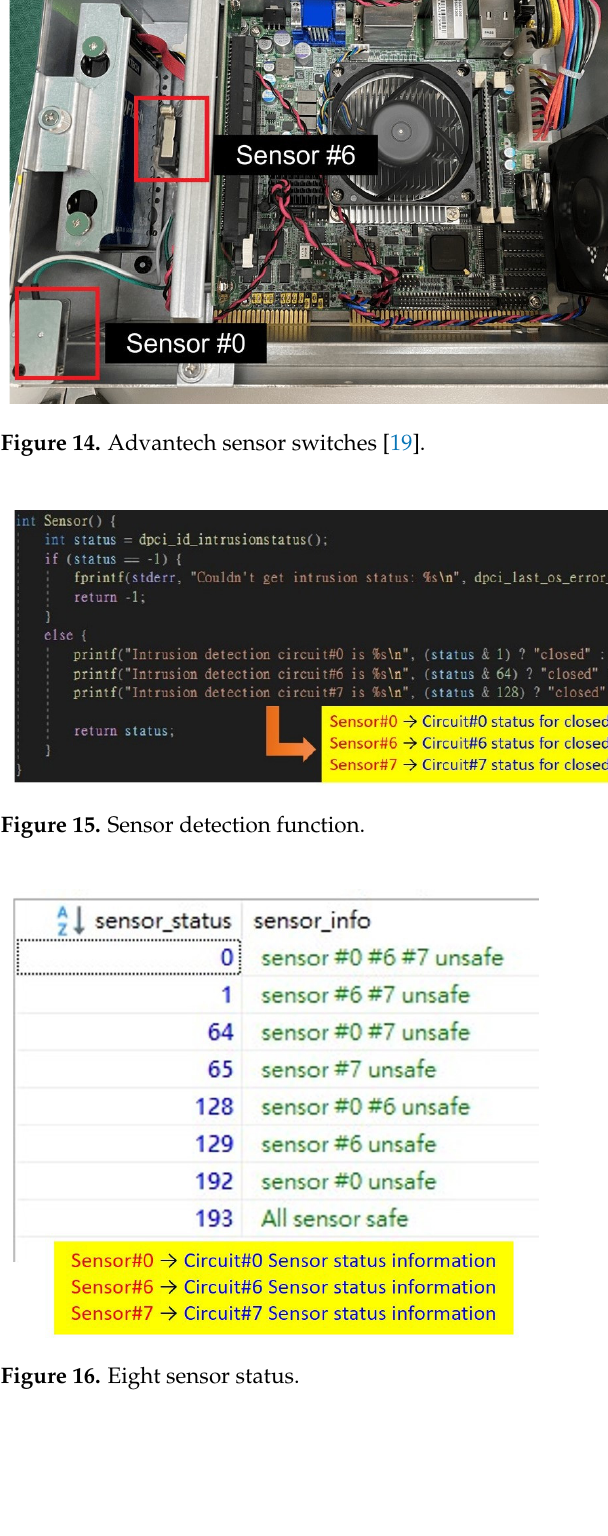
Figure 17. EEPROM function.